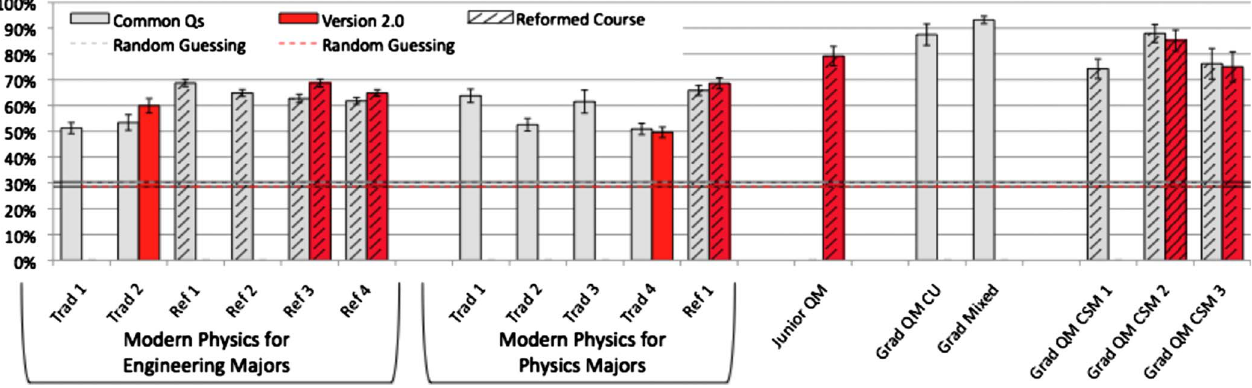
FIG. 2. (cid:1) Color (cid:2) Average posttest scores in different courses for common questions (cid:1) gray/light (cid:2) and Version 2.0 questions (cid:1) red/dark (cid:2) . Solid colored bars indicate courses taught with traditional instruction and cross-hatched bars indicate reformed courses. Error bars show standard error on the mean. All scores are post-test scores except for Grad QM CU, which is from a pre-test for an introductory graduate quantum course at CU, and Grad mixed, which is from a survey given over the summer to graduate students from different universities who may or may not have taken a graduate quantum